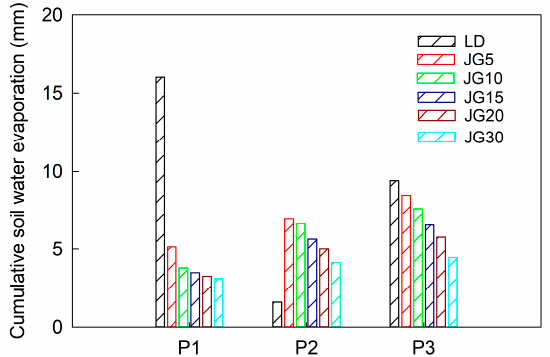
Figure 7. Soil water evaporation with different straw mulch thicknesses during the three freeze–thaw Figure7. stages.